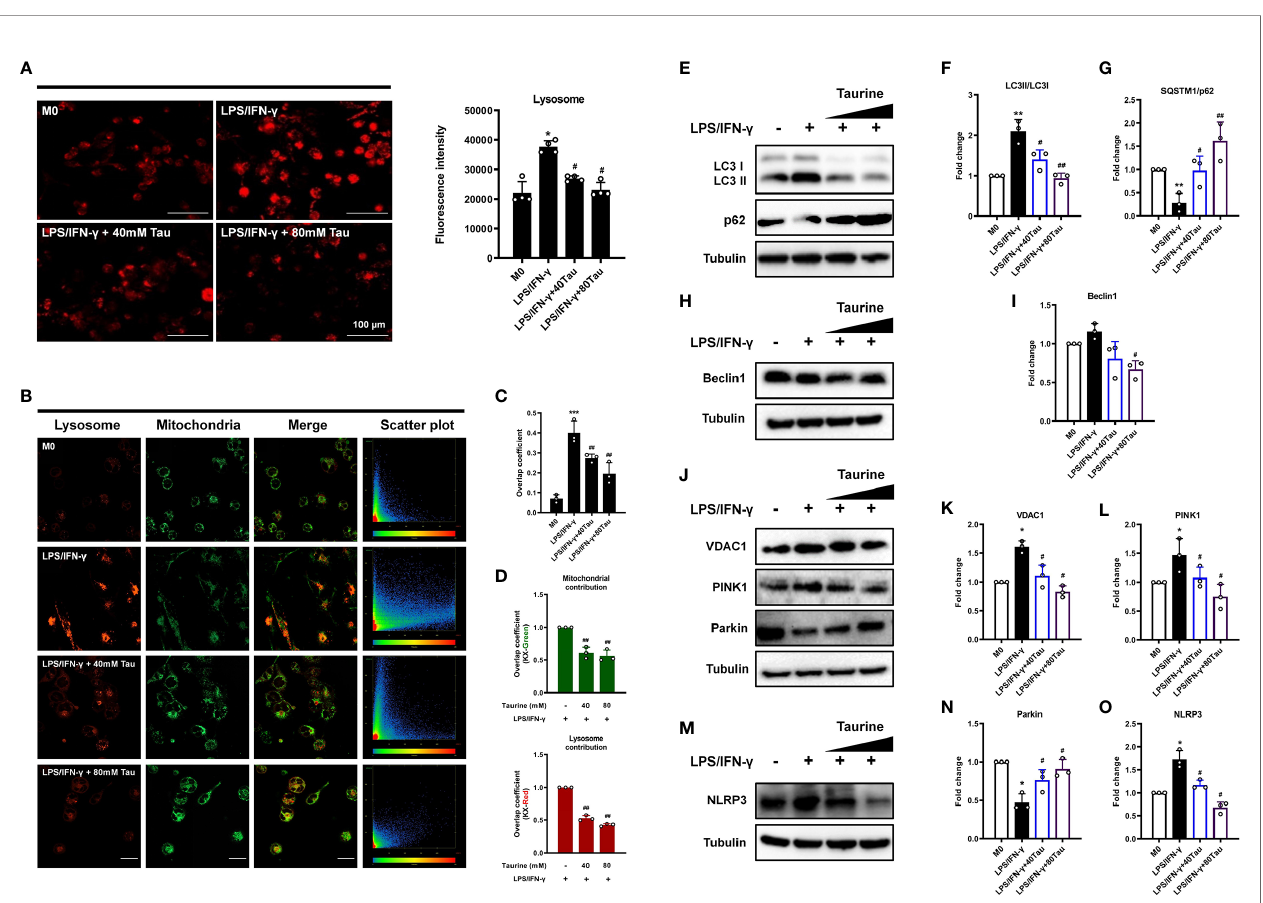
FIGURE 4 | Taurine blocks mitophagy in LPS/IFN- g -challenged macrophages. (A) Fluorogram of lysosomes in M1 macrophage and its quanti fi cation analysis, n=4. (B) Colocalization analysis of endocytic probes. Mitochondria (green), lysosome (red) and the merged images, and the scatterplot of red and green pixel intensities. Scale bar, 20 m m. (C) Pearson ’ s correlation coef fi cients (PCCs) of merged images, n=3. (D) Quanti fi cation of the overlap coef fi cient (Left: Kx-green/ Right: Kx-red) in the merged images, n=3. (E – O) Representative immunoblots and quantitation of LC3 II/I, p62, Beclin-1, VDAC1, PINK1, Parkin, and NLRP3, n=3. *p < 0.05, **p < 0.01 and ***p < 0.001 vs. M0; #p < 0.05 and ##p < 0.01 vs. LPS/IFN- g